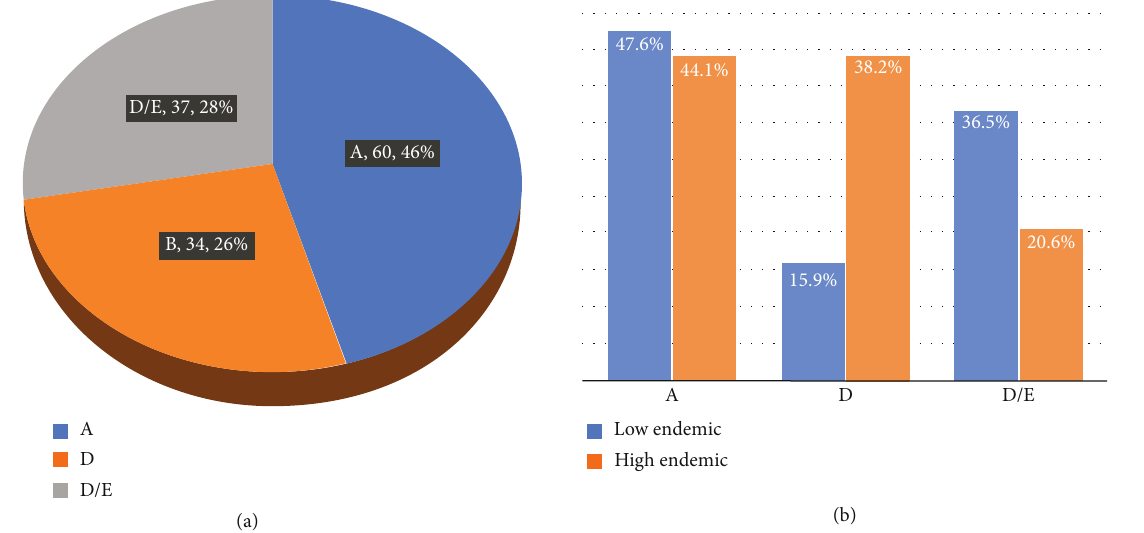
Figure 3: Genotype prevalence: (a) overall prevalence of the circulating genotypes; (b) genotype prevalence by endemicity.